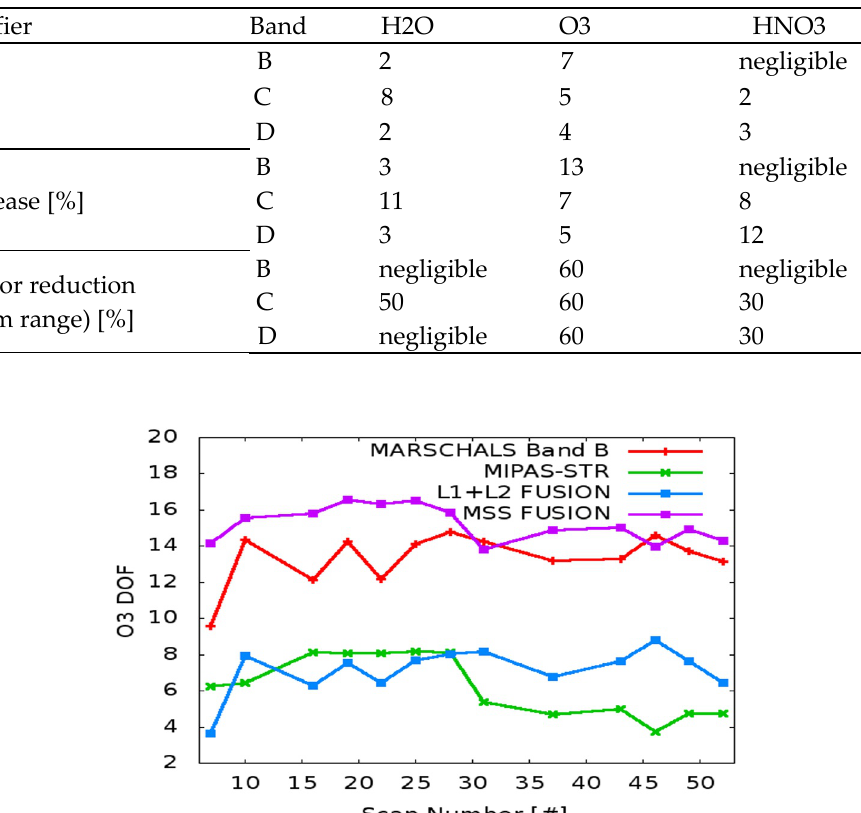
Table 1: DOFs, GI increase in % and total retrieval error reduction in % with respect to MIPAS-STR obtained from the (L1+L2) data fusion method for H 2 O, O 3 , and HNO 3 in each MARSCHALS Band.